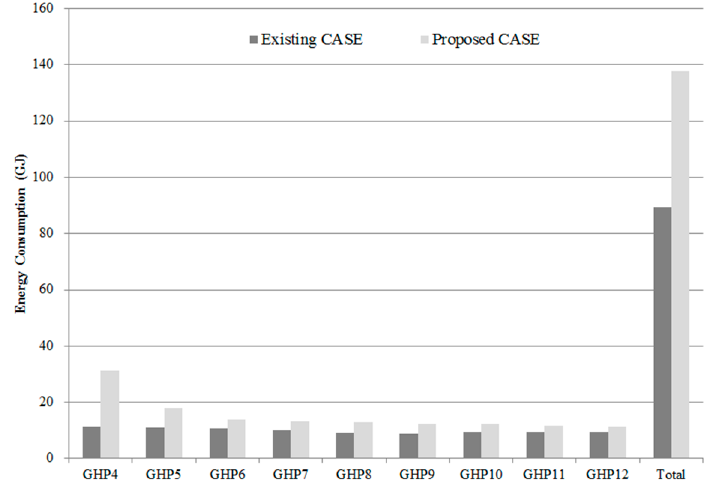
Figure 12. Indoor temperature in the proposed CASE: ( a ) Summer; ( b ) Winter.